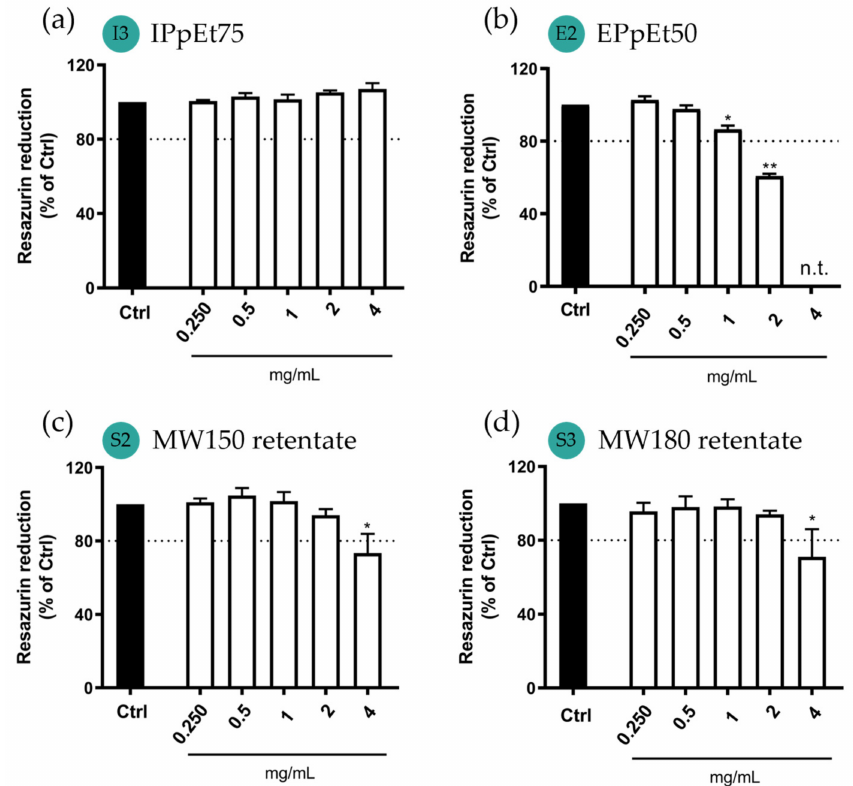
Figure 7. Effect of microparticle exposure for 24 h on cellular viability of human alveolar epithelial cells (A549 cell line) using microparticles made from ( a ) IPpEt75; ( b ) EPpEt50; ( c ) MW150 retentate; and ( d ) MW180 retentate. n.t.—not tested. Data correspond to the mean ± SEM of at least three independent experiments performed in duplicate and are represented as a % of untreated cells